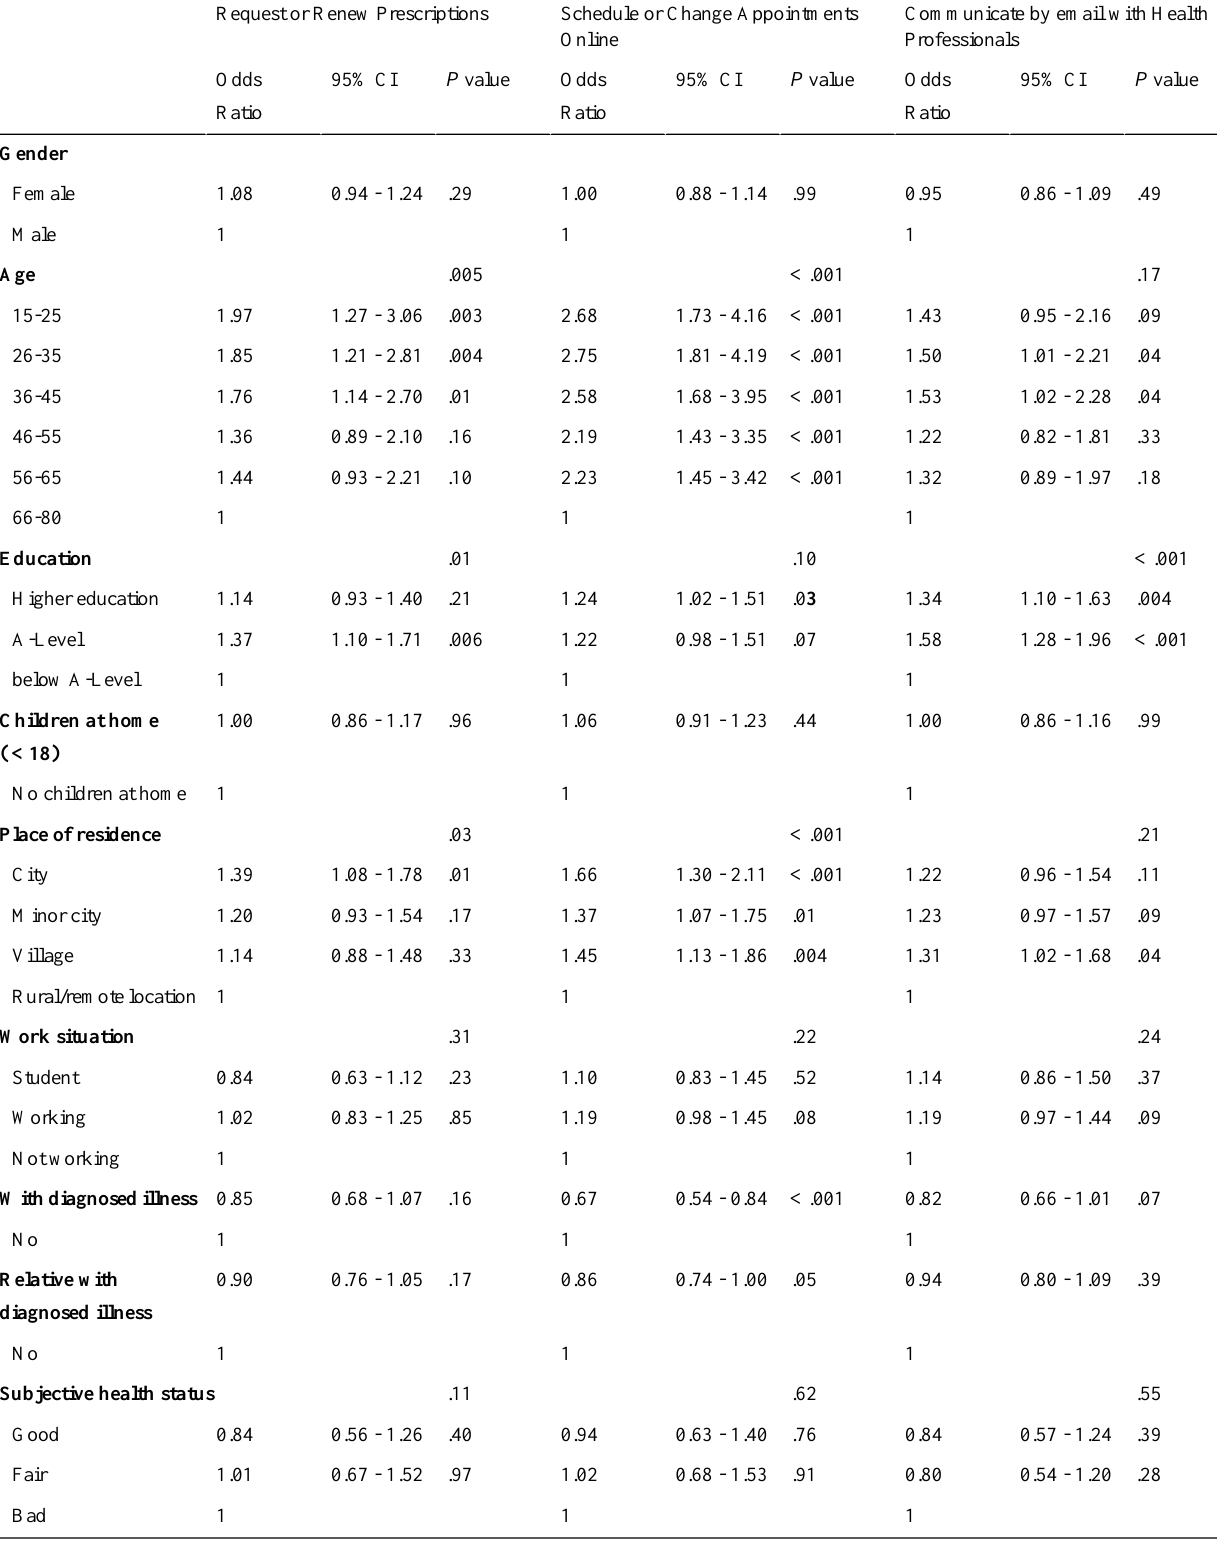
Table 4. Characteristics of health-related Internet users who value eHealth services when choosing a new doctor in 2007